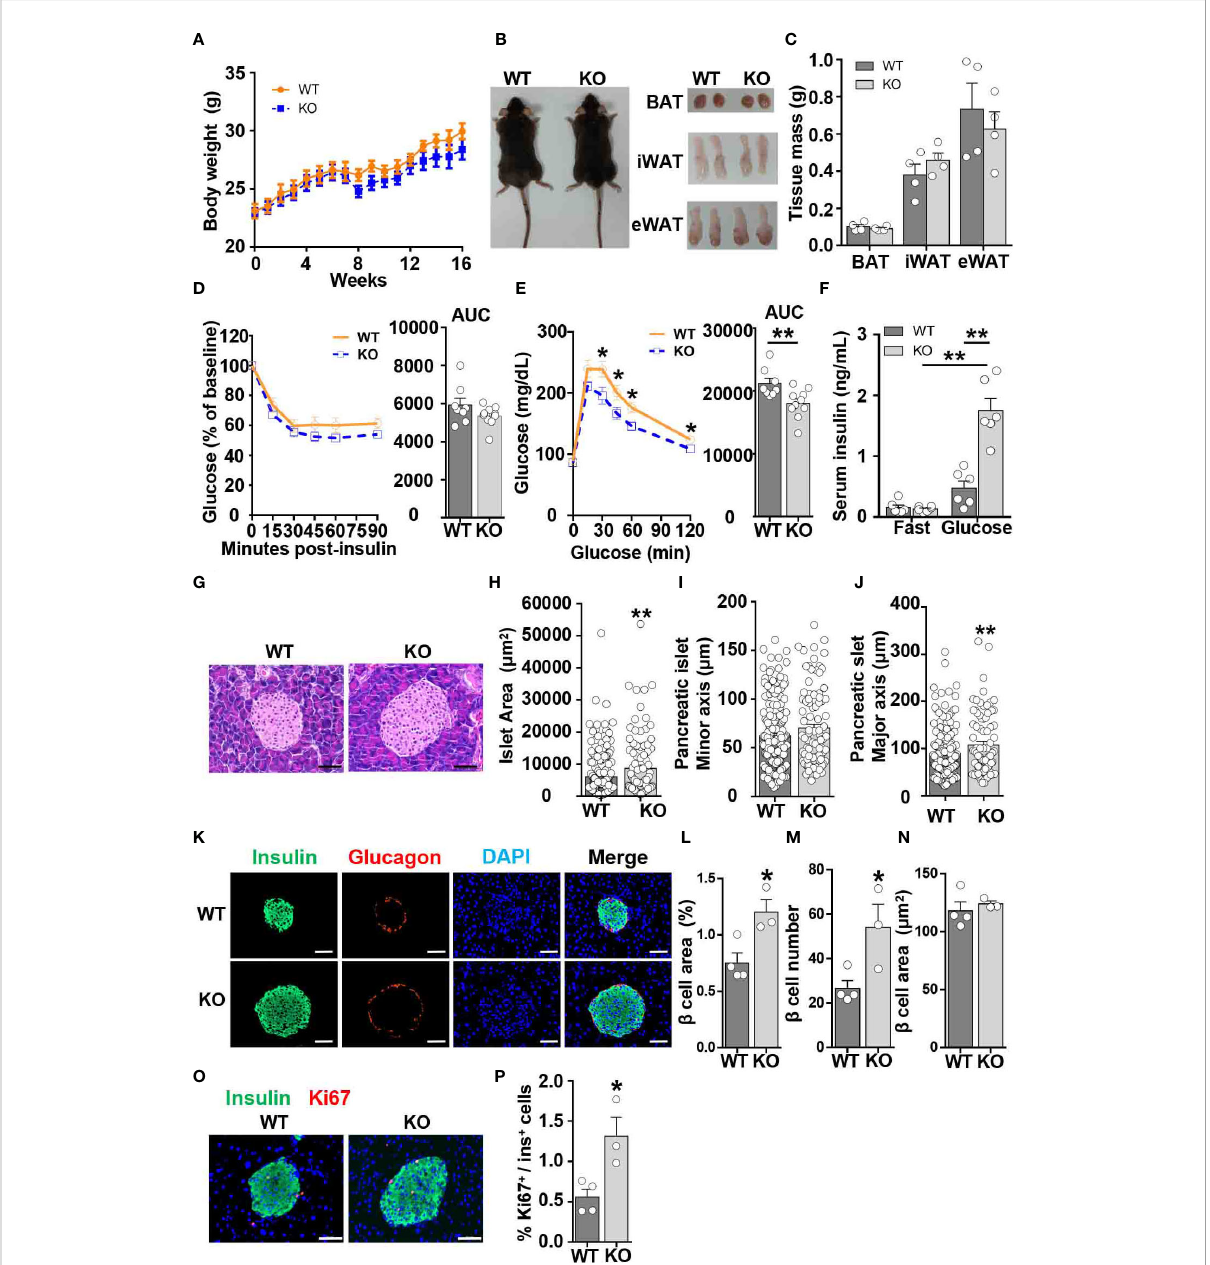
FIGURE 2 CCL5 de fi ciency enhances glucose tolerance in ND-fed mice. (A) Body weights of WT and CCL5 KO mice fed an ND. (n = 4-6 mice per group). (B) Representative images of mice and each part of fat pad (BAT, iWAT, and eWAT). (C) Weight of BAT, iWAT, and eWAT of WT and CCL5 KO mice fed an ND. (n = 4-6 mice per group). (D, E) ITT (D) and GTT (E) in mice fed an ND (n = 8-10 mice per group). (F) Serum insulin levels of ND-fed mice after 6 h fasting (fast) or 15 min after 1g/kg glucose injection (glucose). (n = 6 mice per group). (G) Representative H&E staining of pancreatic islet section. Scale bar: 50 m m. (H – J) area (H) , minor axis (I) , and major axis (J) of each pancreatic islet. (n = 4 mice per group. Data shown in panels (H – J) were obtained from the analysis of 16 sections). (K) Representative immuno fl uorescent staining of the islets of mice fed an ND using anti-insulin (green) and anti-glucagon (red) antibodies. (L) b cell mass of WT and CCL5 KO mice fed an ND. (n = 3-4 mice per group). (M) b cell number per islet of WT and CCL5 KO mice fed an ND. (n = 3-4 mice per group). (N) The size of individual b cell in WT and CCL5 KO mice fed an ND. (n = 3-4 mice per group). (O) Representative immuno fl uorescent staining of the islets of mice fed the ND using anti- insulin (green) and anti-ki67 (red) antibodies. Arrows indicate insulin + Ki67 + cells. Scale bar: 50 m m. (P) Percentages of insulin + Ki67 + cells in pancreatic sections of WT and CCL5 KO mice fed an ND. (n = 3-4 mice per group). Data in (C – E, H – J, L – N, P) are mean ± s.e.m. * p <0.05, ** p <0.01 by unpaired Student ’ s t-test. Data in (F) is mean ± s.e.m.* p <0.05, **p<0.01 by two-way